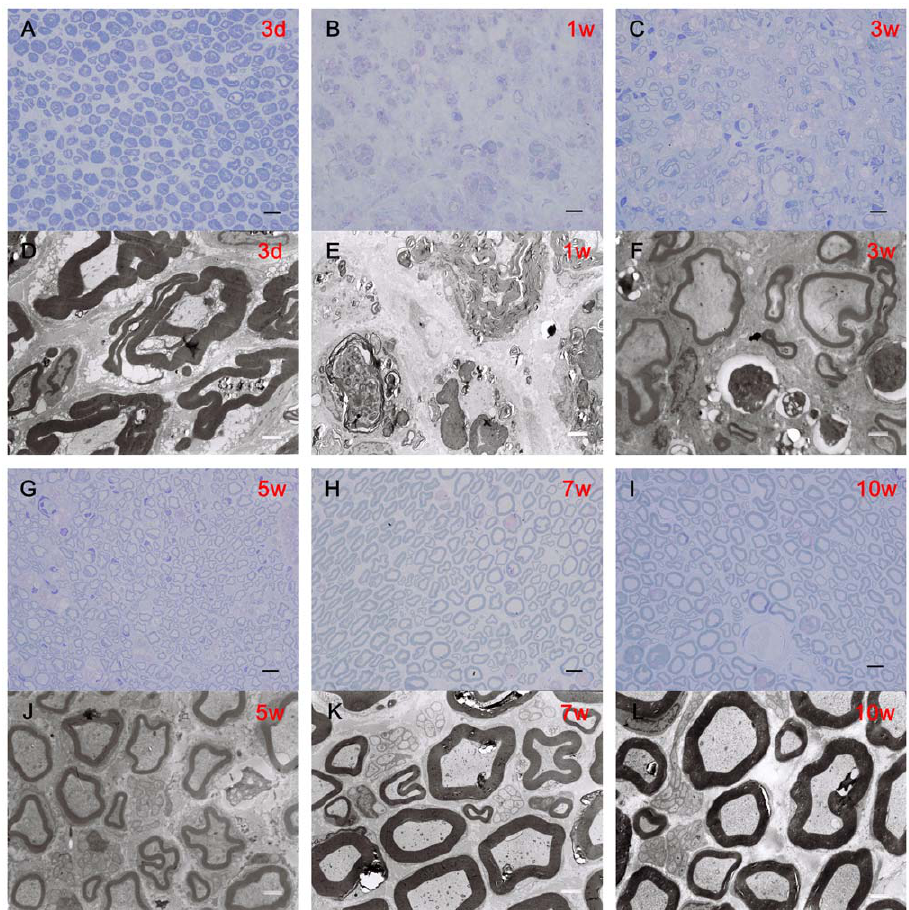
Figure 2. Remyelination of sciatic nerves. (a–c, g–i) Toluidine blue staining. Light micrographs of transverse semi-thin sections at the injury sites of IRE at 3 days, 1 week, 3, 5, 7 and 10 weeks after injury. (d–f, j–l) Transmission electron micrographs(TEMs). Ultra-thin sections at the injury sites of IRE at 3 days, 1 week, 3, 5, 7 and 10 weeks after injury were observed under TEM. Scale bars : A–C, G–I, 10 m m. D–F, J–L, 1 m m.